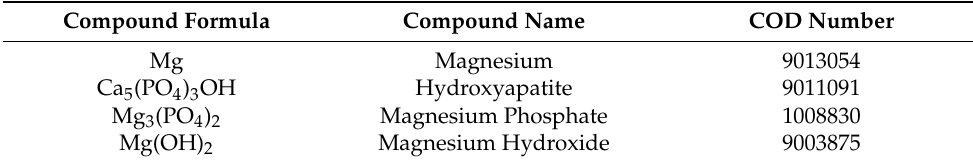
Table 8. Sample compounds after seven days of SBF immersion on